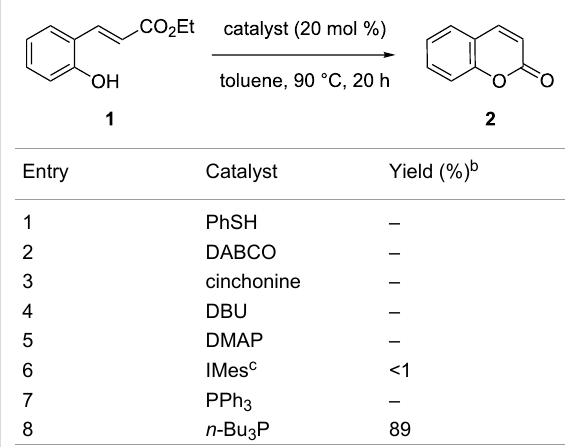
Table 1: Screening of catalysts for nucleophilic double-bond isomer- ization. a